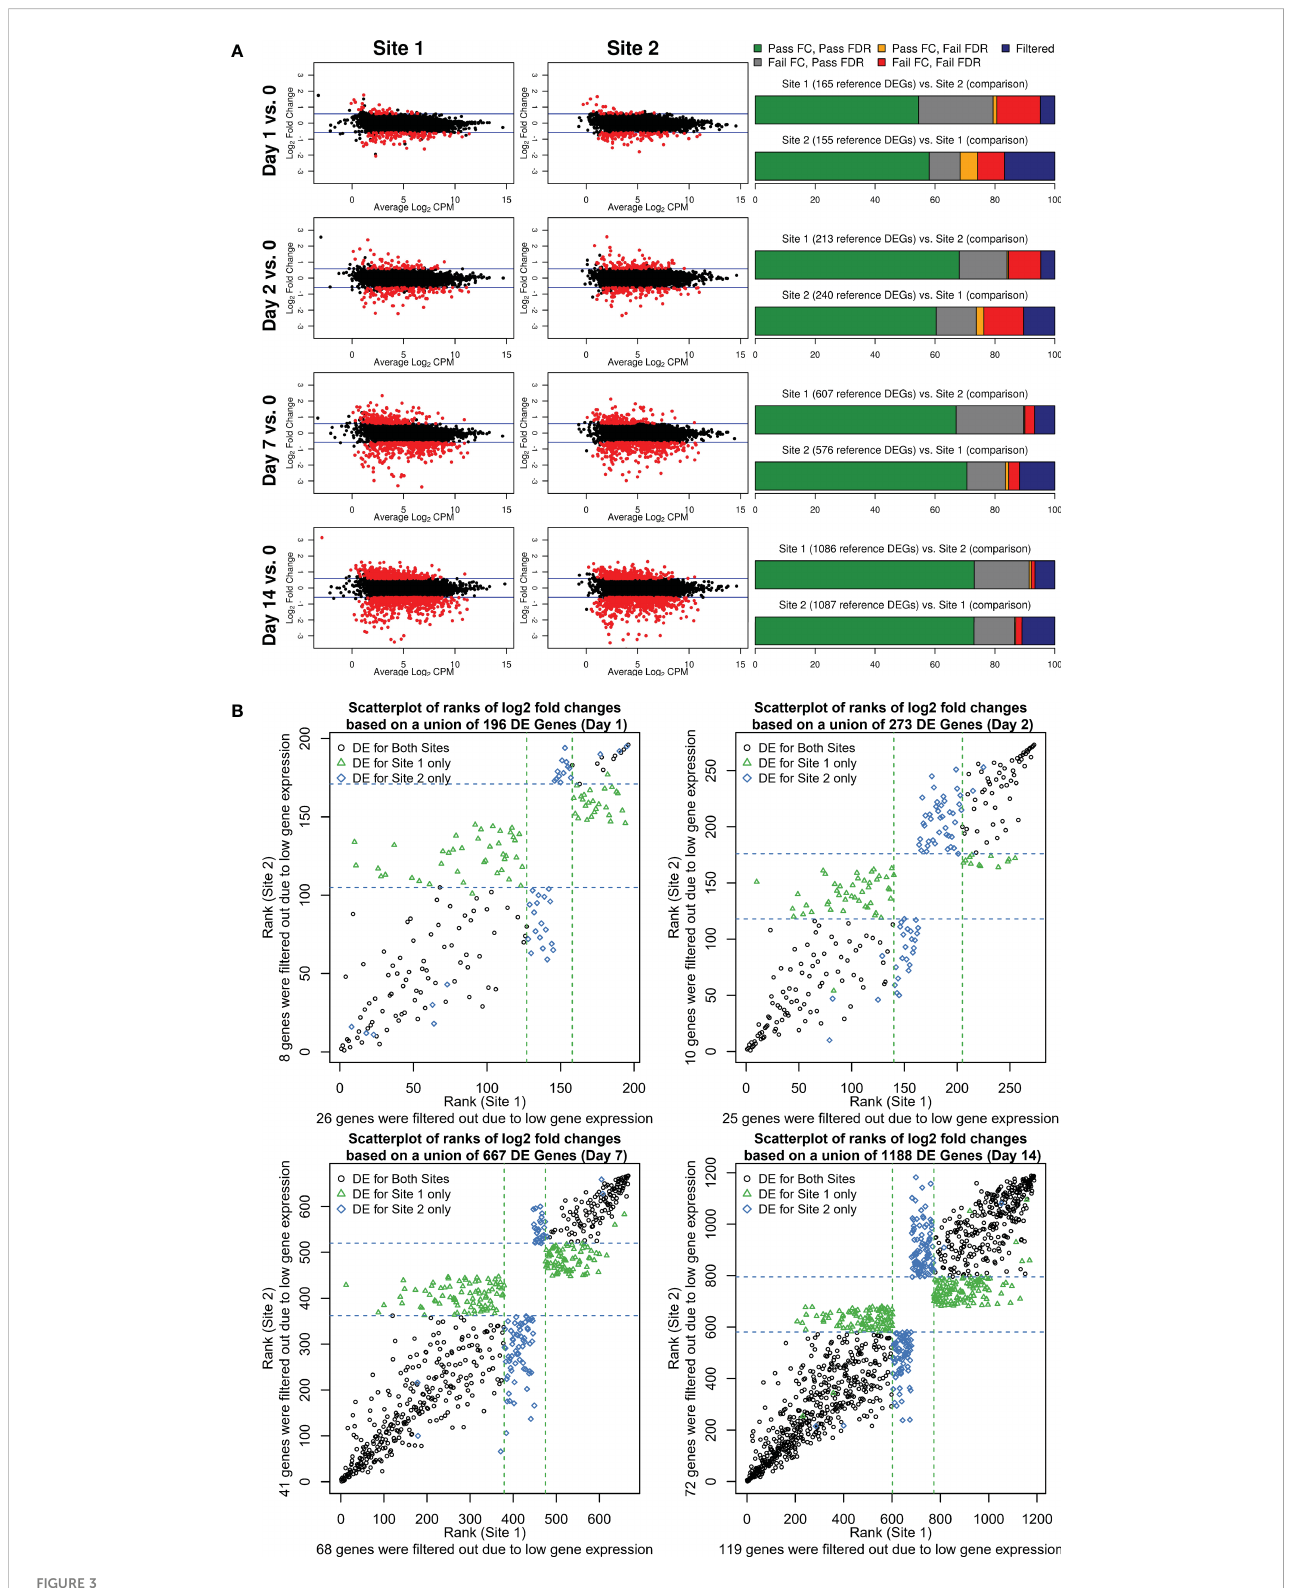
FIGURE 3 (A) Fold change and DEGs over time. MA plots shown to the left contrast average log 2 fold changes from pre-vaccination (y-axis) by average gene expression levels (log 2 CPM as shown on the x-axis) for each site and post-vaccination time point. Blue lines indicate the pre-speci fi ed minimum fold- change cutoff of ±1.5 fold. DEGs (edgeR FDR <0.05, fold change ≥ ± 1.5 in either direction, and maximum read count of >8 CPM across all samples) are colored in red. Stacked bar plots to the right summarize the overlap between the two sites. The fi rst bar plot for each post-vaccination day represents DEGs identi fi ed for Site 1 color-coded by the overlap class for genes identi fi ed for Site 2 (combination of FDR and fold change criteria or CPM gene fi ltering criterion that were met/not met). The second barplot shows the reverse presenting a characterization of Site 2 DEGs based on the overlap with Site 1 genes. (B) Scatterplots of ranks of log 2 fold changes based on a union of DEGs identi fi ed for each site by post-vaccination day. A rank of 1 corresponds to the lowest log 2 fold change. Dashed lines represent the upper and lower rank boundaries of the ≥ 1.5 fold-change cutoff for each